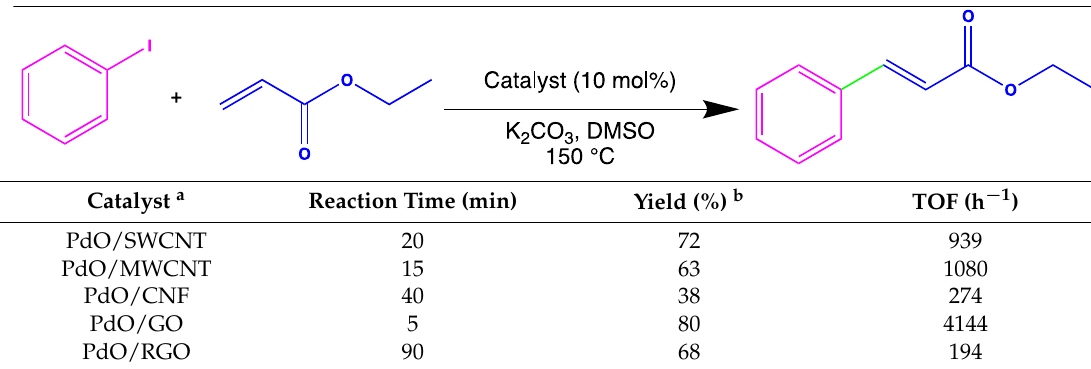
Table 2. Performance of PdO supported carbon materials in the Heck coupling reaction [32] (Adapted with permission from John Wiley and Sons).